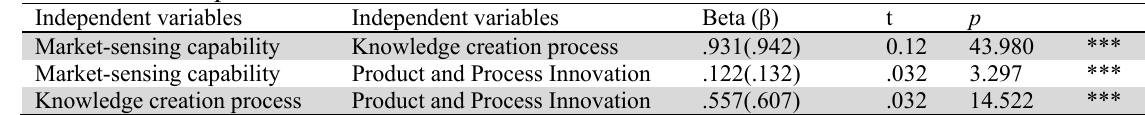
Fig. 2. Structural Equation Model, Resulted from SMEs Results of the implementation of